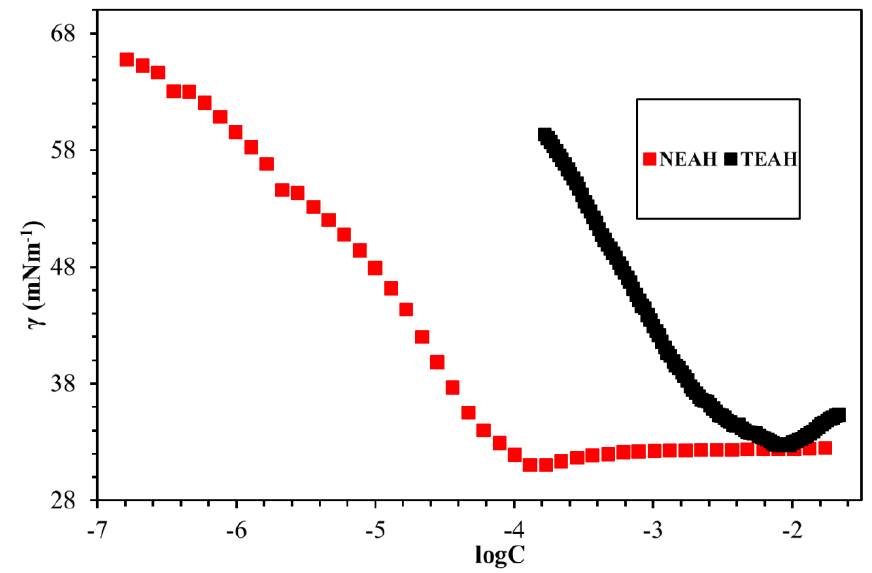
Figure 11. Comparison of surface tension of TEAH in DW and in 1M NaCl at 30 °C.